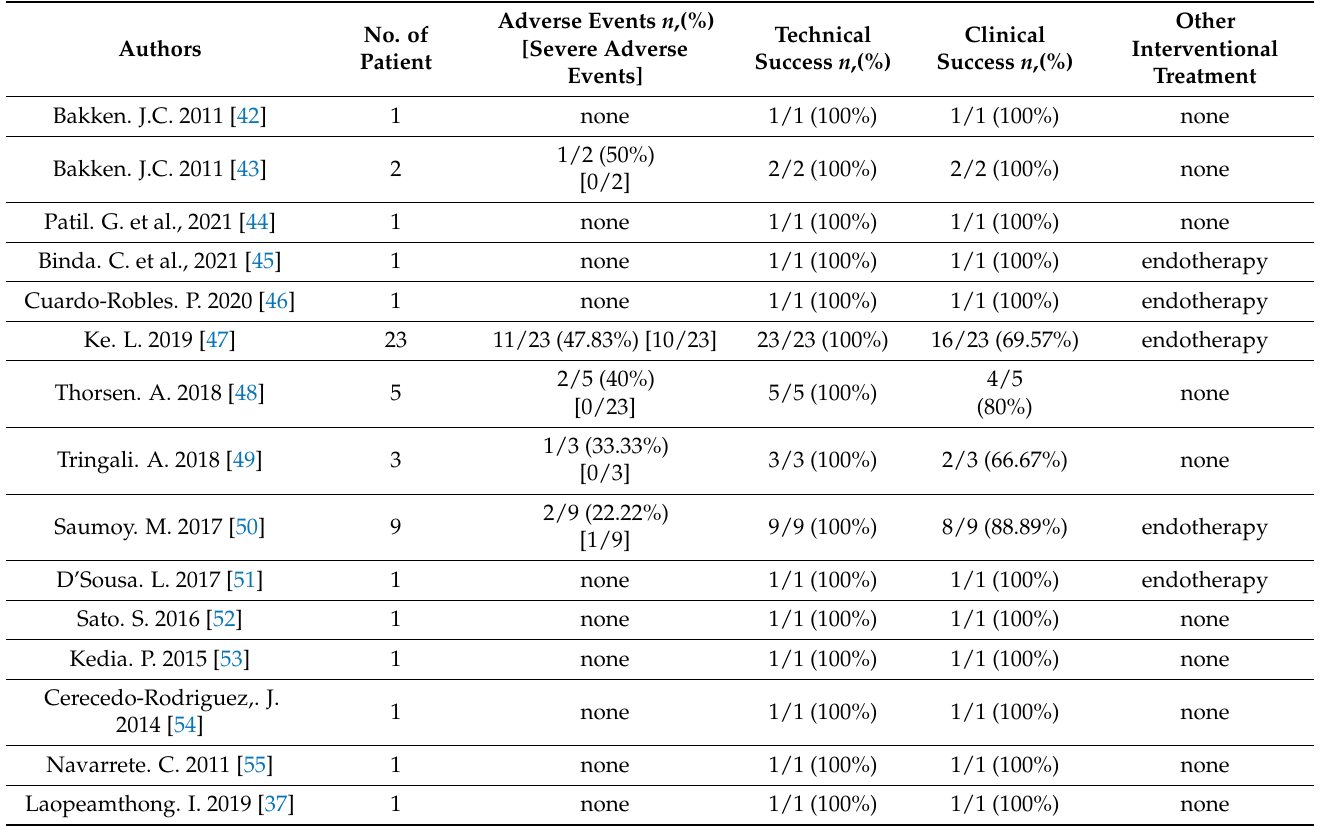
Table 1. All publications regarding percutaneous endoscopic necrosectomy in current literature together with number of